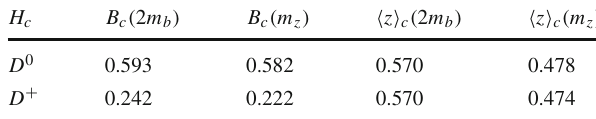
Table 6 Same as Table 5 but at NNLO accuracy